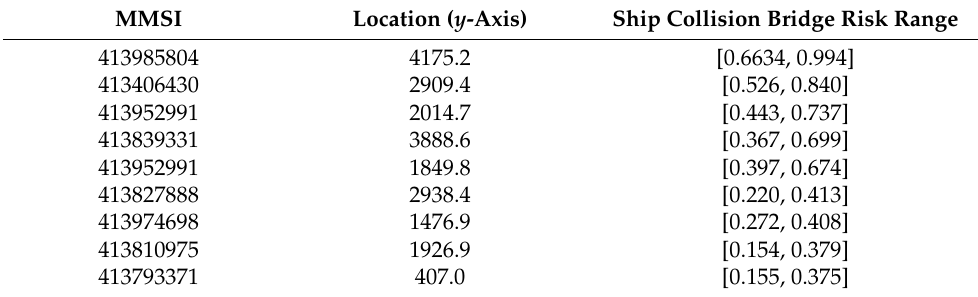
Table 2. T ship risk